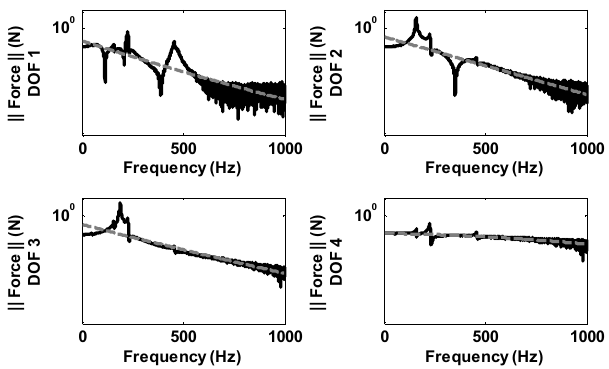
Fig. 4. Force estimates (——) and their curve-fit lines (– – –) for the shaped based technique used to identify a damaging impact on the 4-DOF model. of producing damage is applied to a structure, the maximum amplitude of the damaging force will be much greater than the amplitudes of random noise